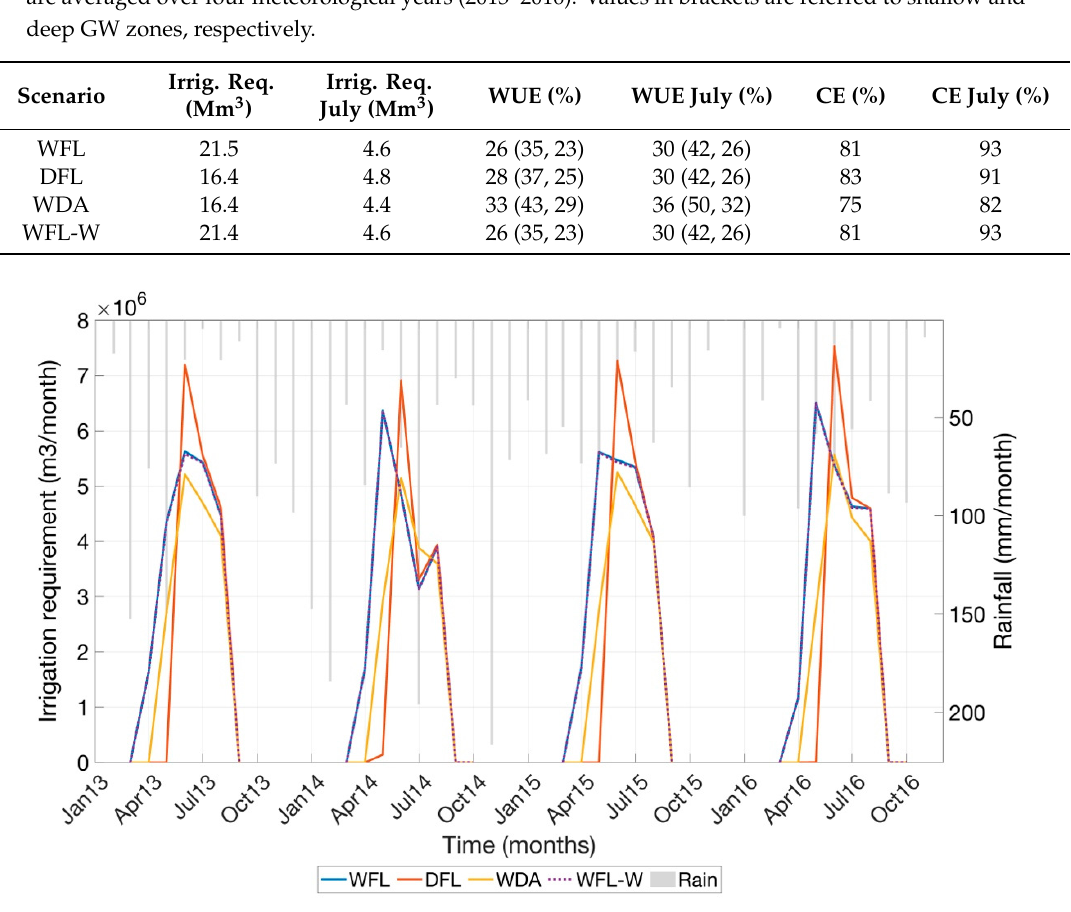
Figure 11. Simulated monthly district total irrigation requirement during the agricultural seasons (15 April–15 September) 2013–2016 for the four irrigation scenarios in the W-San Giorgio di Lomellina district.